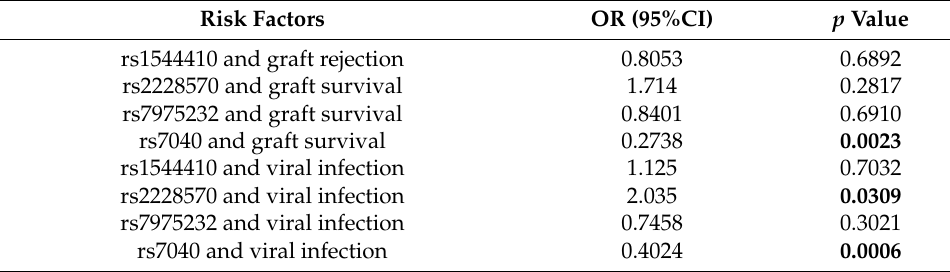
Table 3. The correlation between the genotypes and the allograft outcome. Risk Factors